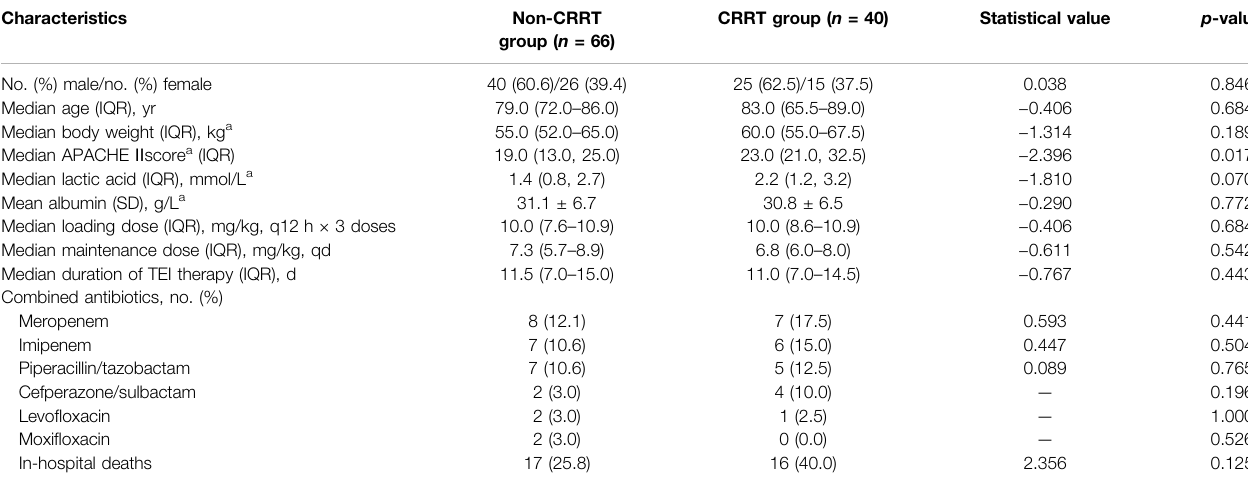
TABLE 1 | Baseline characteristics and anti-infection treatments in two groups. Characteristics